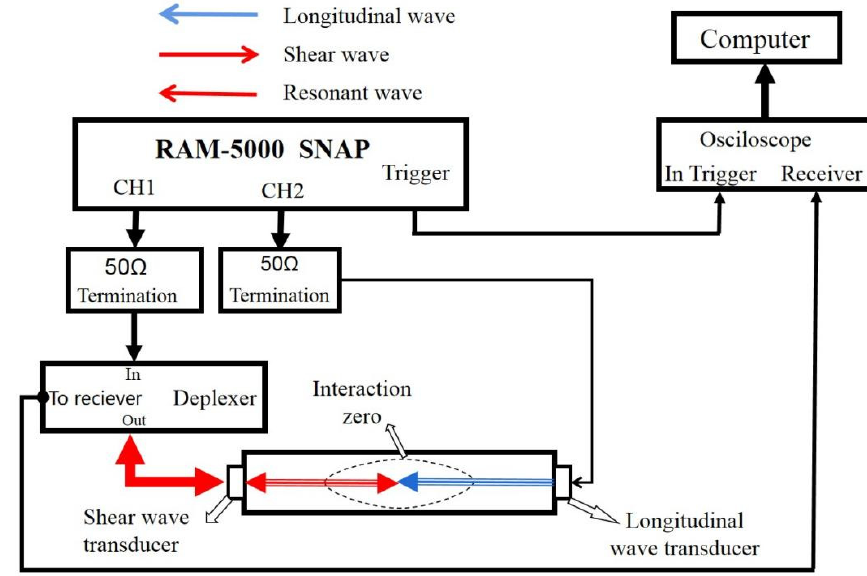
Figure 3. The theory about an experimental system.